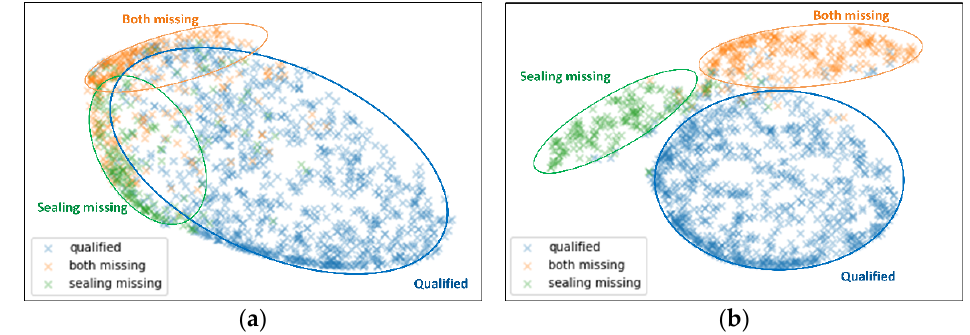
Figure 7. T-SNE visualization of the training set: ( a ) supervised learning; ( b ) the proposed method.